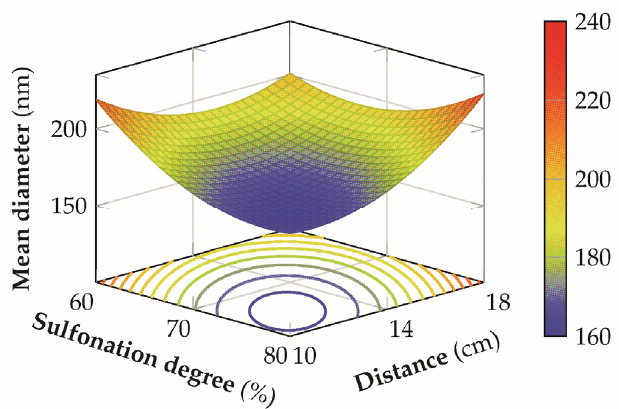
Figure 8. 3D response surface of the mean diameter for the sulfonation degree versus distance at an applied voltage of 25 kV and a flow-rate of 0.125 mL/h.